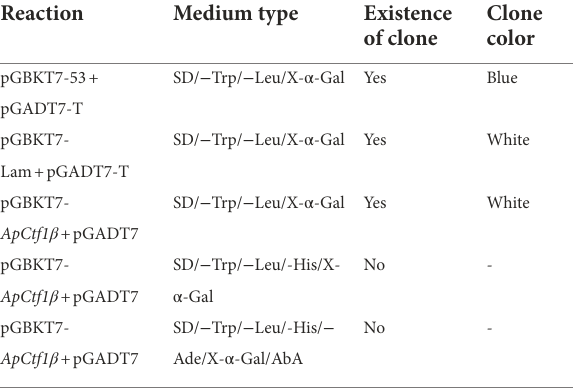
TABLE 1 Self-activation and toxicity assay reaction